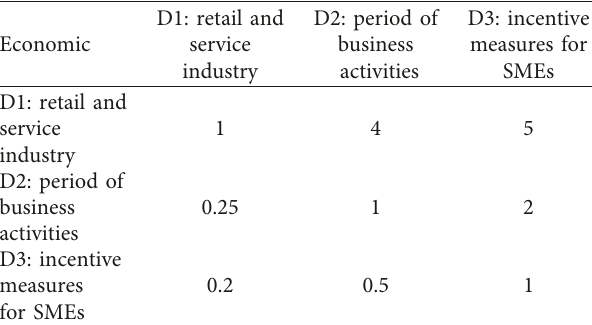
Table 6: Matrix of economic criteria.